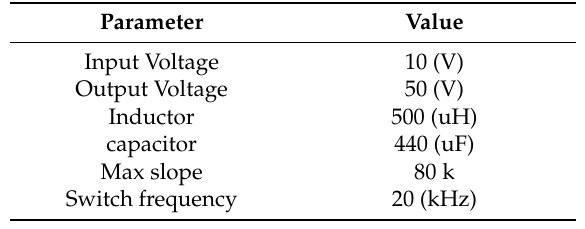
Table 1. System parameters.